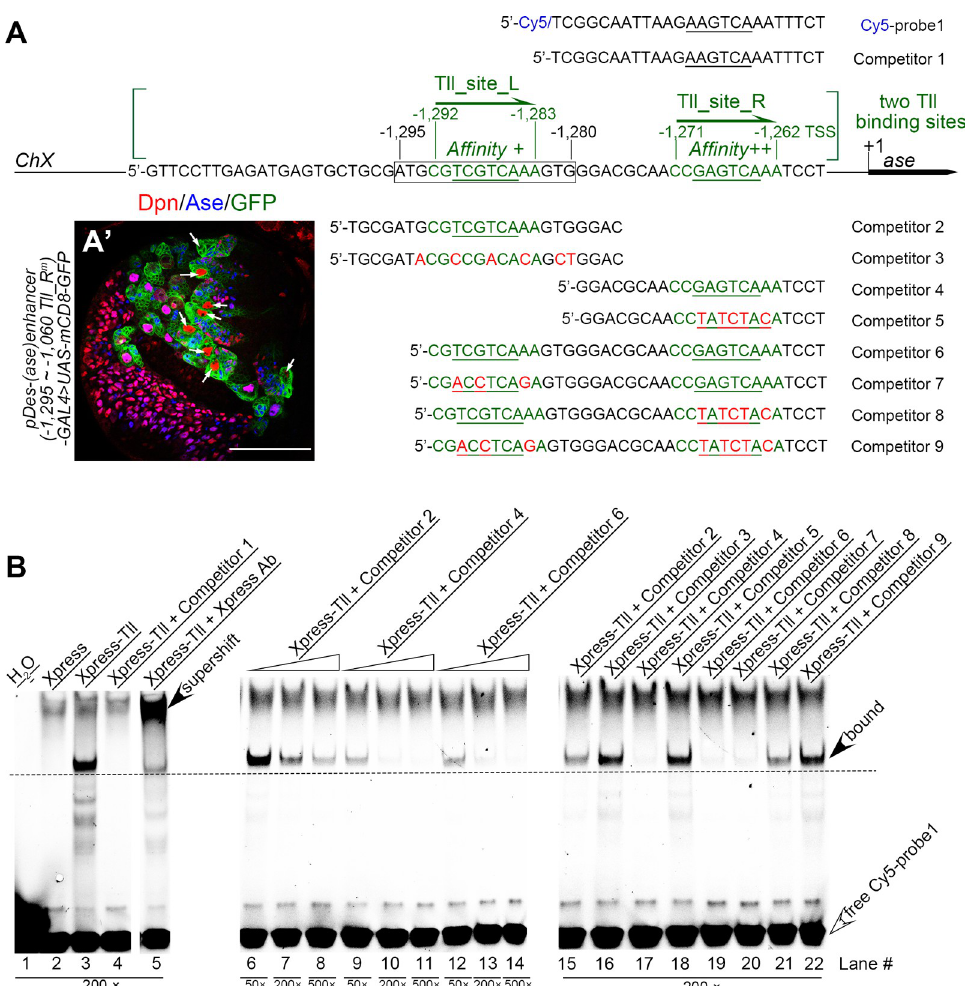
Fig 3. Tll directly binds to ase regulatory regions. (A) Sequences of a Cy5 labeled probe and various competitors used in EMSAs are shown. Cy5-probe1 and competitor 1 contain a sequence from a kr enhancer sub-fragment with the underlined hexameric 5’-AAGTCA half-site core sequence that are bound by Tll proteins. Other competitors contain sequences from the ase regulatory region with the predicted Tll binding sites, Tll_site_L and/or Tll_site_R, shown in green. The underlined sequences are the core half-sites of the Tll DNA binding motifs. Red nucleotides indicate mutations introduced into the predicted Tll binding sites. (A’) mCD8-GFP driven by the pDes-(ase)enhancer-GAL4 driver that contains a wild type Tll_site_L site and a mutated Tll_site_R site is expressed in both type I NB lineages and type II NB (white arrows) lineages. Scale bars equal 50 μ m. (B) Binding between Xpress-tagged Tll proteins and Cy5-probe1 and its competition by indicated competitors. Open arrowheads point to free Cy5-probe1 at the bottom of gels, while filled arrowheads point to the lagged bands of the complexes of Tll-Cy5-probe1 or the super-shifted band of the complexes of Xpress Ab-Tll-Cy5-probe1. Numbers under corresponding lanes indicate the ratios of competitors to probes. Specific binding between Tll and Cy5-probe1 is detected in lane #3 and verified in lane #5 by the presence of a super-shifted band when the Xpress antibody is present. Specific competition is detected when competitors that contain the wild type sequence of either one (competitors #2, #4, #7, and #8, corresponding to lanes #6–11 and #20–21) or both (competitor #6, corresponding to lanes #12–14 and #19) of the predicted Tll binding sites are present, but not when competitors that contains only mutated sites (competitors #3, #5, and #9, corresponding to lanes #16, #18, and #22). However, competitors that contain only the wild type Tll_site_L site (competitors 2 and 8, corresponding to lanes #6–8, #15, and #21) have relatively weak competition compared to competitors that contain only the wild type Tll_site_R site (competitors #4 and #7, corresponding to lanes #9–11 and #20) or both wild type sites (competitor #6, corresponding to lanes #12–14 and